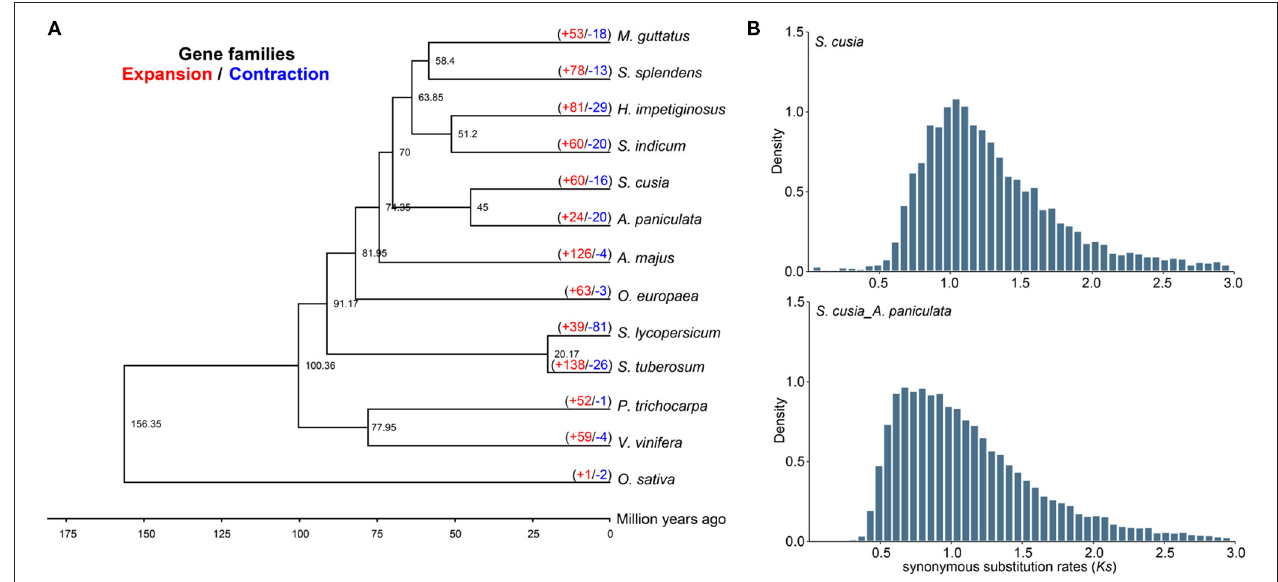
FIGURE 3 | Comparative genomic and phylogenetic relationship analyses. (A) Phylogenetic relationship between S. cusia and other representative plant species. The divergence times among different plant species are labeled in the bottom. The red number on each branch represents expansion gene families, and blue number indicates the number of contracted gene families. (B) Density distribution of Ks values between syntenic genes of compared